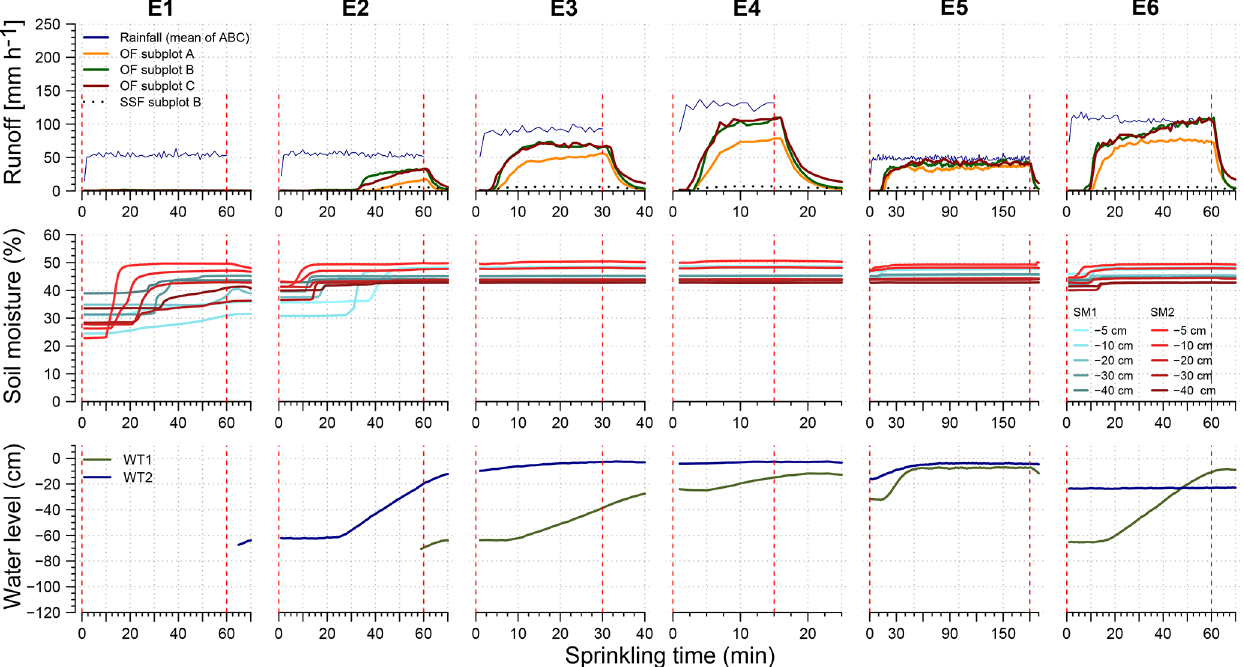
Figure 5. Example for runoff reactions, soil moisture and temporary saturated soil zone for experimental site 11 on pasture for the six single simulations of extreme rainfall.